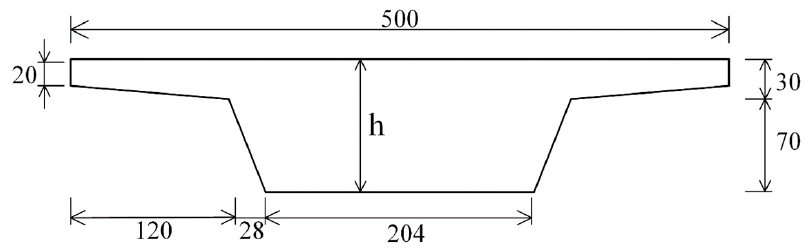
Figure 9. Configuration of the box girder (units: mm). Figure 9. Con fi guration of the box girder (units: mm). Figure 9. Con fi guration of the box girder (units: mm). Figure 9. Con fi guration of the box girder (units: mm).